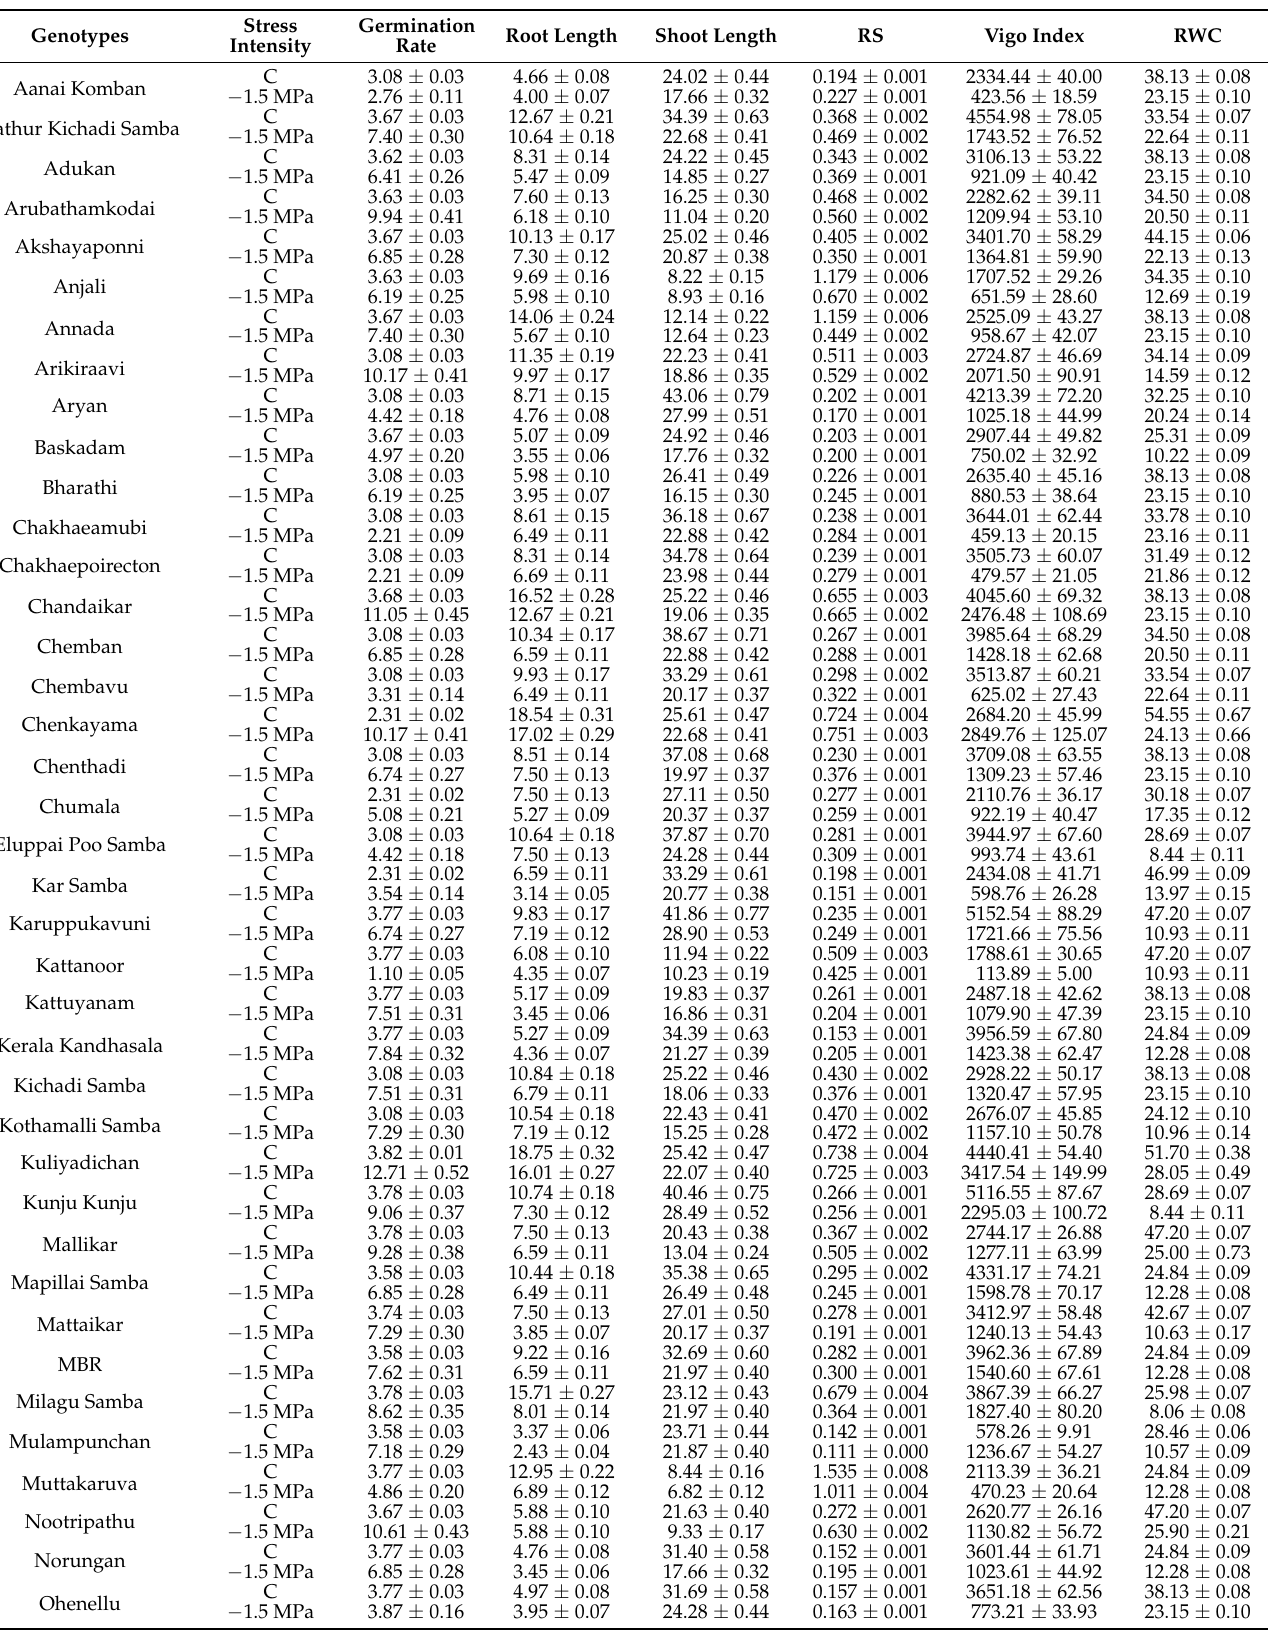
Table 1. Comparison of mean values between osmotic stress ( − 1.5 MPa) and non-stressed (C) traditional rice